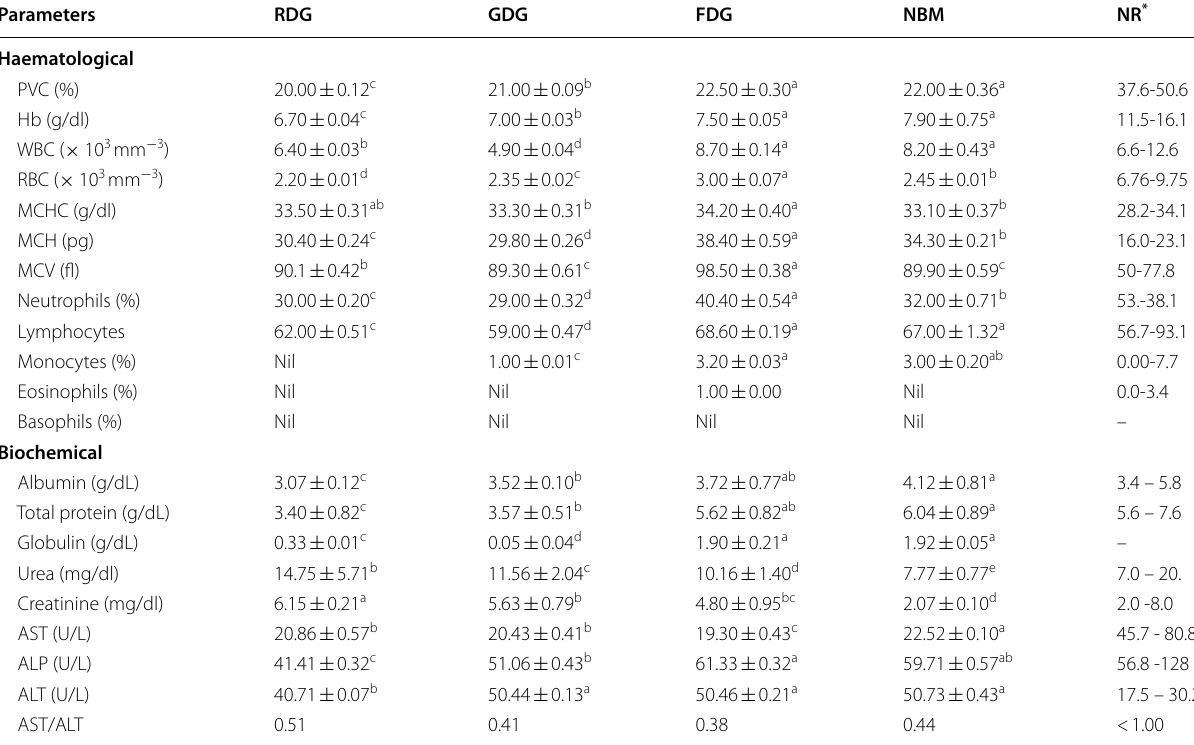
RDG Raw maize, defatted groundnut and ginger in ratio